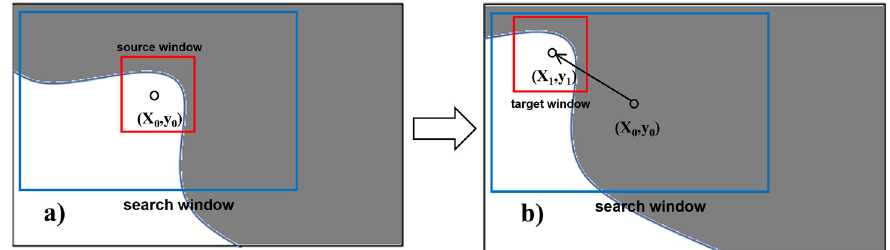
Figure 2. Two consecutive remote-sensing image images T 0 ( a ) and T 1 ( b ), used for calculating the cross-correlation coefficient of the source window (red square) and the target window in the search window (blue square) to search for the position of the highest cross-correlation value and to obtain the velocity vector.